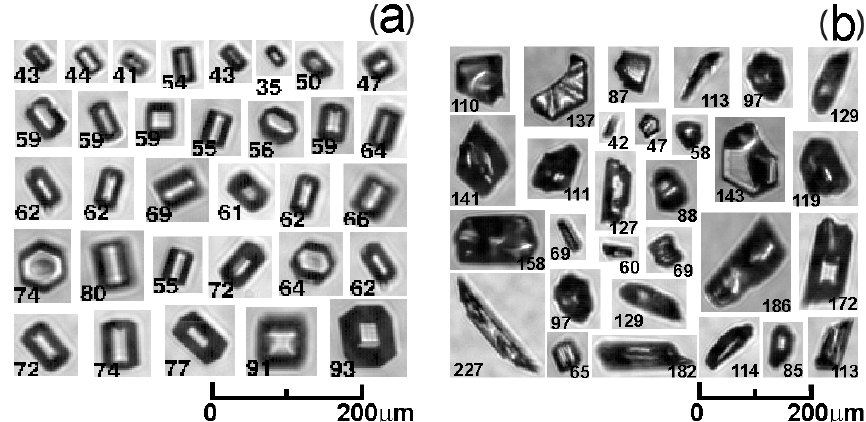
Figure 3. (a) Examples of CPI images used for neural net training to identify small faceted ice crystals. These ice crystals were collected in the mesoscale convective clouds at altitudes 6200 < H < 7000m and temperature range of − 10 ◦ C < T a < − 3 ◦ C. (b) Examples of images misidentified by the image recognition software as pristine faceted ice. The numbers below each image frame indicate maximum size of the images in